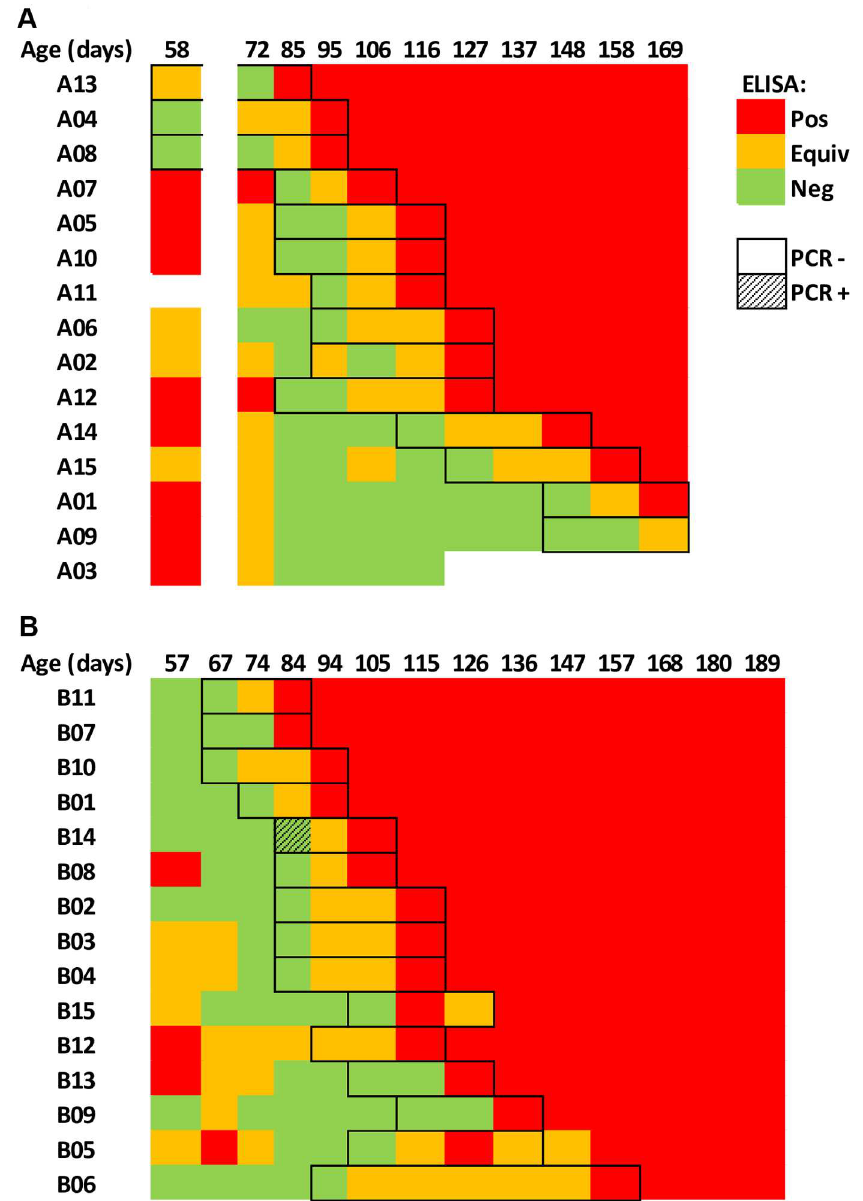
Fig 1. Summary of the ELISA and RT-PCR results of pig sera tested for Japanese encephalitis antibodies and virus